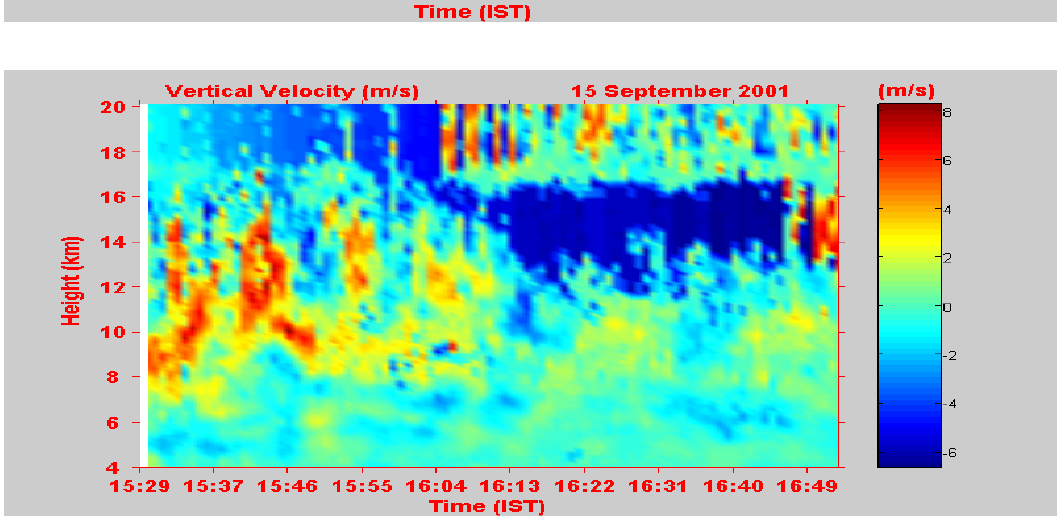
Fig. 7. Image plot of signal-to-noise ratio (SNR), spectral width and vertical velocity on 15 September 2001 during the convection event. Fig. 7. SNR represents signal strength, spectral width is an indication of turbulence and vertical velocity indicates the updraft and downdraft of the